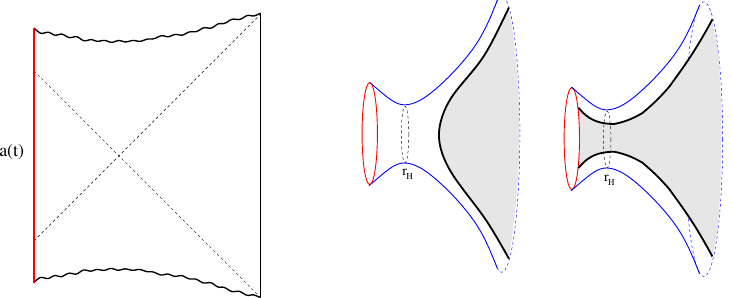
Figure 4 . The dual geometry for | b, τ 0 i for sufficiently small τ 0 is a portion of the maximally- extended AdS-Schwarzchild geometry, cut off by a spherically symmetric ETW brane. The pictures on the right show the spatial slice at t = 0 and the connected and disconnected topologies for the RT surface corresponding to a large interval on the boundary